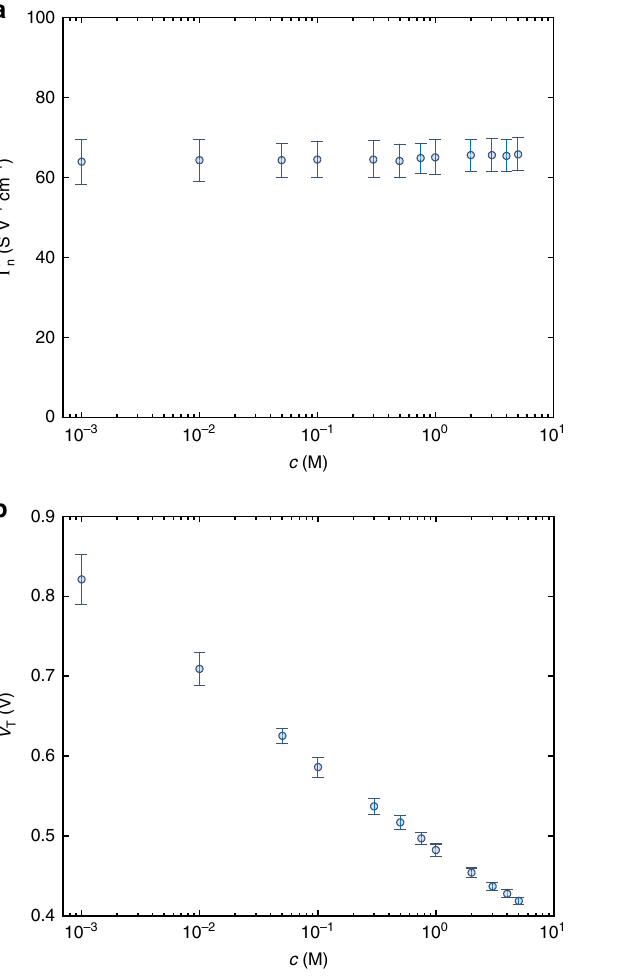
Fig. 3 Potential at the interfaces as a function of the ion concentration. a Measured threshold voltage shift V SH as a function of the ion concentration (symbols) and Nernst potential at the gate/electrolyte interface V G/E (vs. SHE) calculated with Eq. (5) (solid line). b Potential at the electrolyte/polymer interface V E/P as a function of the ion concentration. Symbols are the measurements and solid line is calculated with Eq. (6). Circles are the mean value and error bars are the standard deviation calculated by modeling ten OECTs with various indicates that the contribution of the electrolyte/polymer interface cannot be neglected and it can be calculated with Eq. (4), viz.